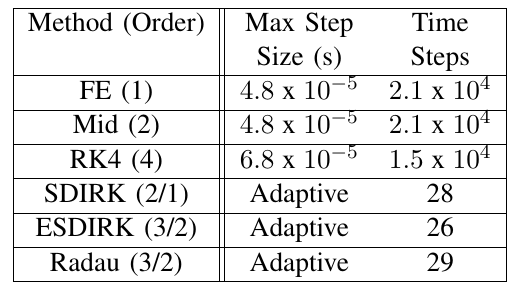
Fig. 5: Simulation step sizes for the GABA TABLE I: Simulation time steps results for the ERK and IRK methods when solving the GABA R model. A